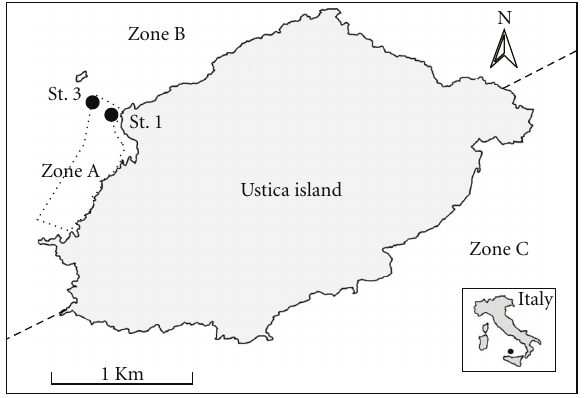
Figure 3: Sampling stations in Zone